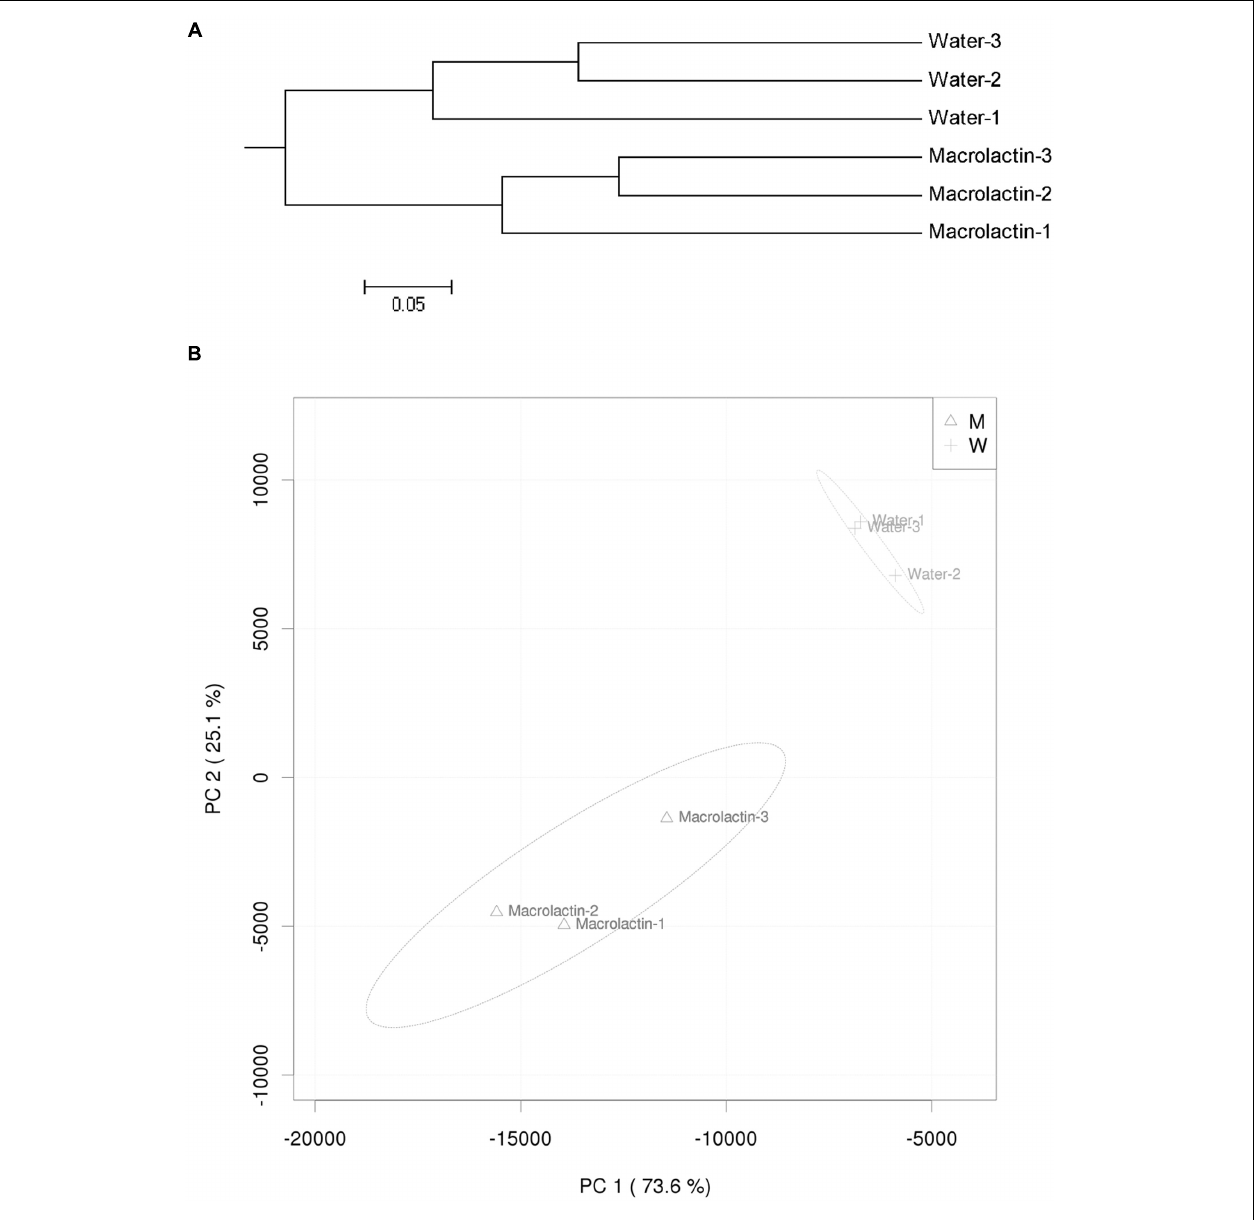
FIGURE 2 | (A) Hierarchical cluster tree constructed based on the distance matrix that was calculated using the unweighted UniFrac algorithm for macrolactin treated soil and water control soil. (B) Principal component analysis (PCA) visualization of the pairwise community dissimilarity (Bray-Curtis index) of all tax levels in the microbial community analyzed by MiSeq sequencing. 95% confidence ellipses are shown around each